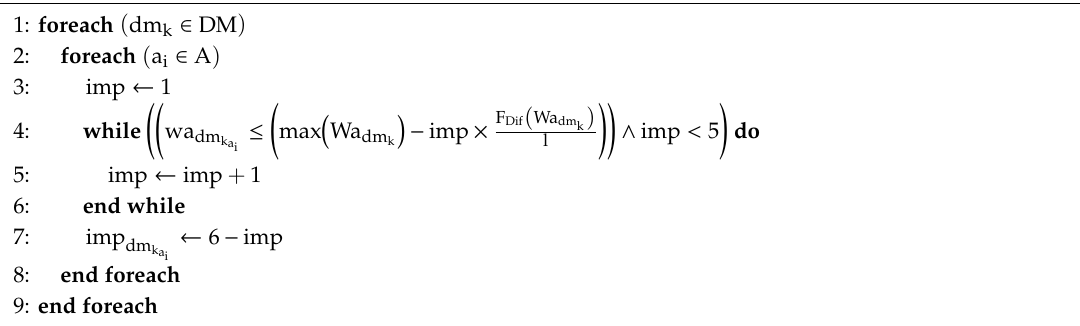
Algorithm 1. Alternatives’ importance classification algorithm.